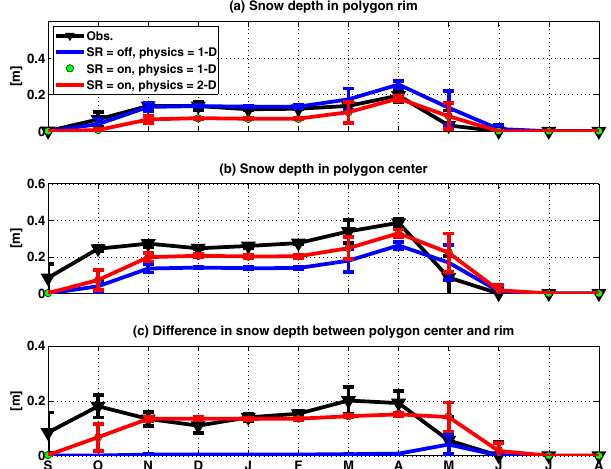
Figure 2. Simulated average winter snow surface elevation across the transect for three scenarios: (1) snow redistribution (SR) turned off and 1-D subsurface physics, (2) snow redistribution turned on and 1-D subsurface physics, and (3) snow redistribution turned on and 2-D subsurface physics. Surface elevation of the transect is shown by the solid black line. The dashed line indicates the bound- ary for comparison to observations in relatively lower (centers) and relatively higher (rims) topographical positions.